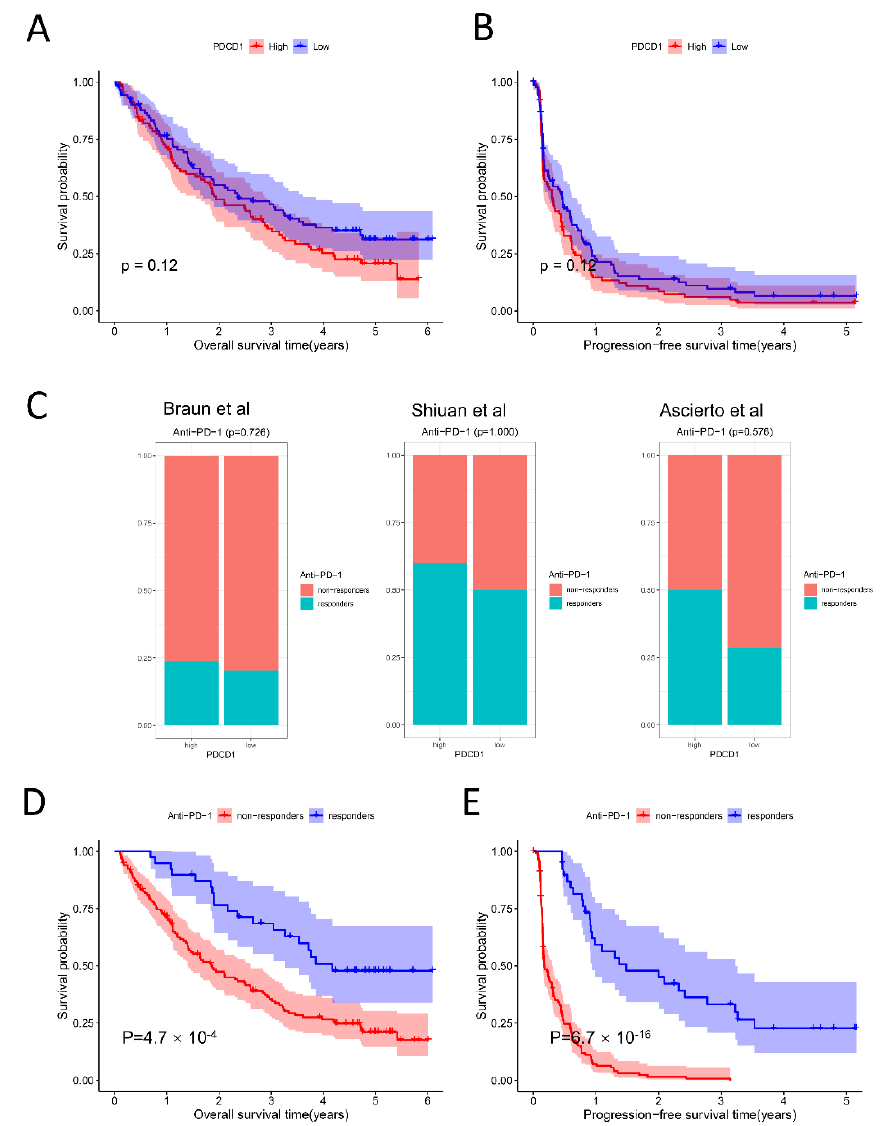
Figure 5. Relationship among PDCD1/PD-1 expression, anti-PD-1 response, and survival. ( A , B ): Correlation between PDCD1 expression and overall survival (left) as well as progression-free sur- vival (right) based on Kaplan-Meier analysis in CheckMate cohort ( n = 181) ( p = 0.12). The patients were dichotomized at the median PDCD1 expression. ( C ): Correlation between PDCD1 expression and anti-PD-1 therapeutic responsiveness in three independent immunotherapy cohorts [29 – 31]. ( D , E ): Survival analysis of overall survival and progression-free survival between anti-PD-1 respon- sive and non-responsive groups in the CheckMate cohort ( n = 172). A total of nine patients who were not evaluated after immunotherapy were excluded from 181 patients. p < 0.05 was considered to be statistically